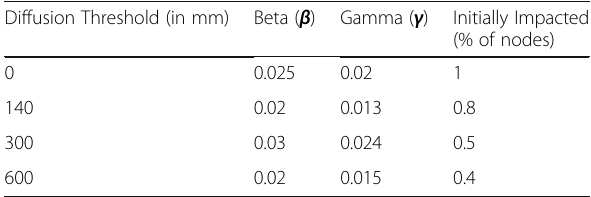
Table 1 Summary of diffusion parameters under different diffusion threshold